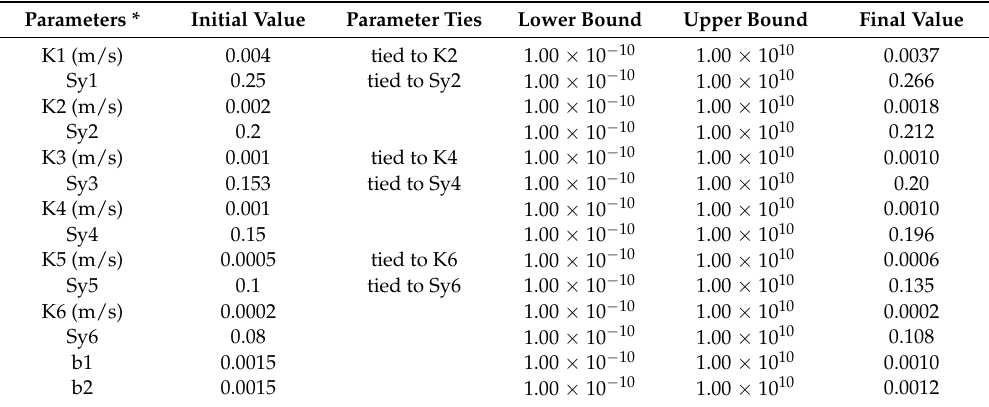
Table 3. Parameters chosen for